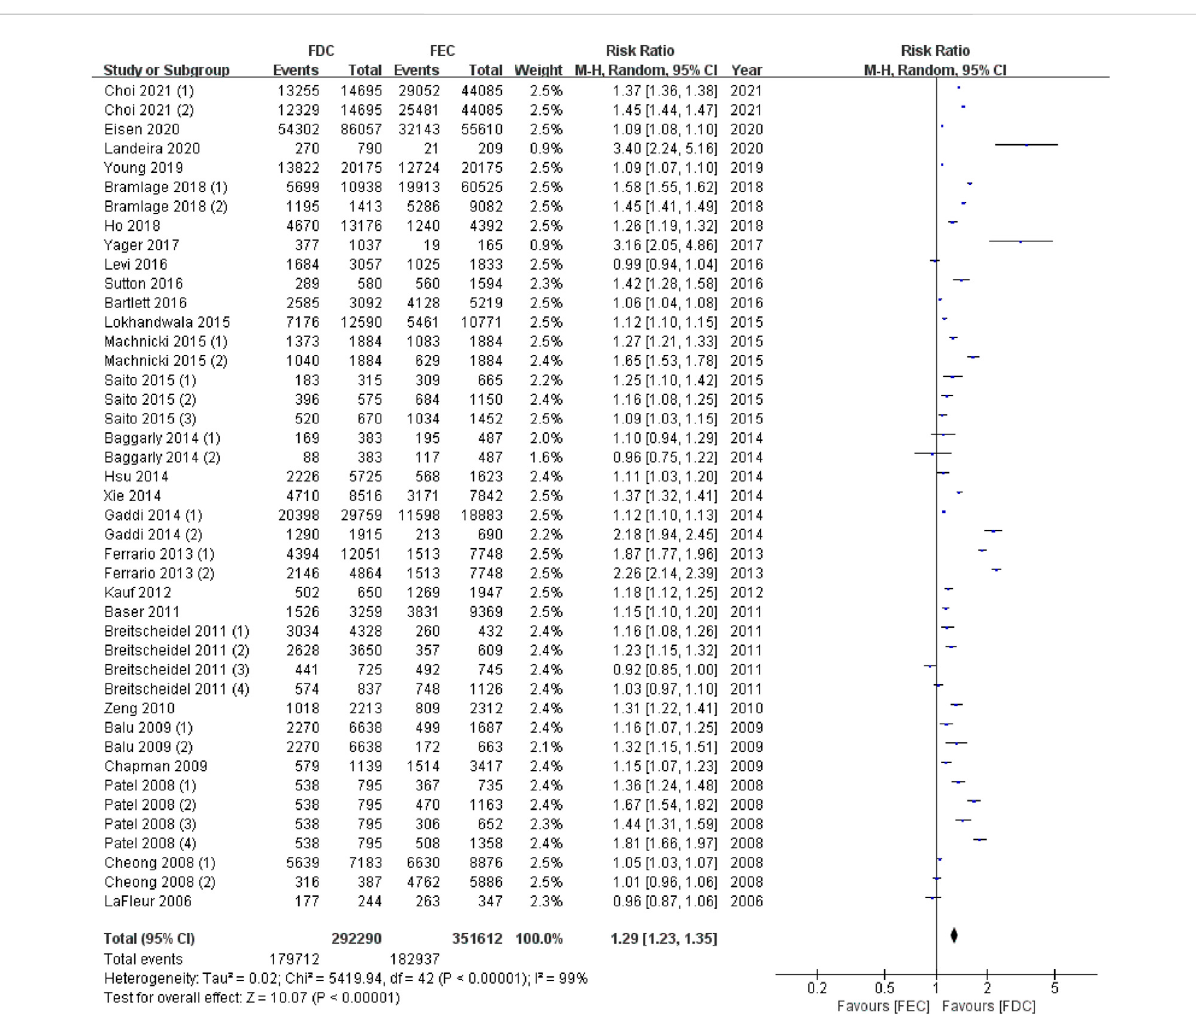
represent high heterogeneity across studies. Likewise, the mean difference in medication adherence between FDC and FEC was 0.10 (95% CI: 0.06 – 0.14, p < 0.00001, Figure 3) with an I 2 estimate of 100%.